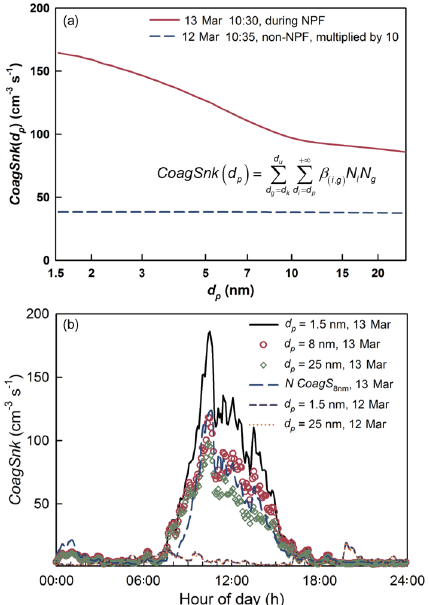
Figure 4. (a) CoagSnk as a function of d p , where d p is the ac- counted minimum diameter when calculating CoagS g for particles at all different d g values, and scavenging due to coagulation with particles smaller than d p is neglected, as defined by the formula in panel (a) . The dashed line corresponding to CoagSnk on a non-NPF day is also monotonously decreasing with the increase in d min by a negligible slope. (b) Time evolution of CoagSnk versus time on an NPF day (13 March) and a non-NPF day (12 March); d p is defined the same as in panel (a) . N is the number concentration of particles in the size range from 1.5 to 25nm, while CoagS 8nm is calculated using Eq.